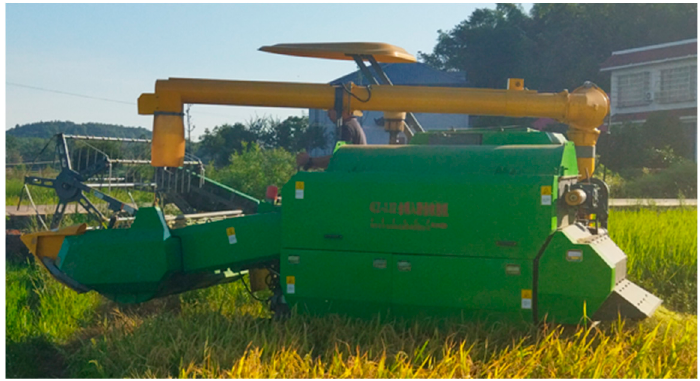
Figure 4. The 4LZ-3.2Z Whole Grain Combine.